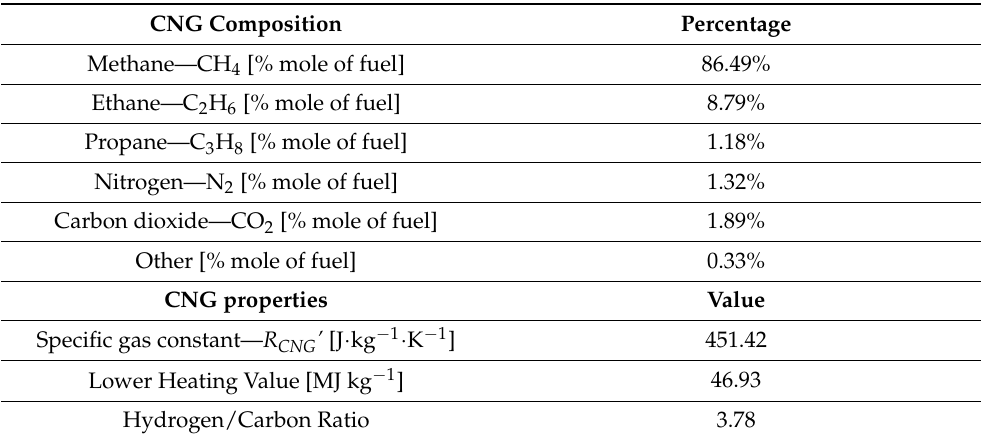
Table 2. Composition and properties of the natural gas considered